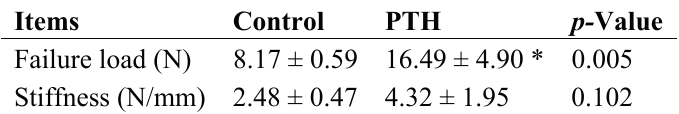
Table 3. Biomechanical test (mean ± SD). * indicates significant difference between groups.